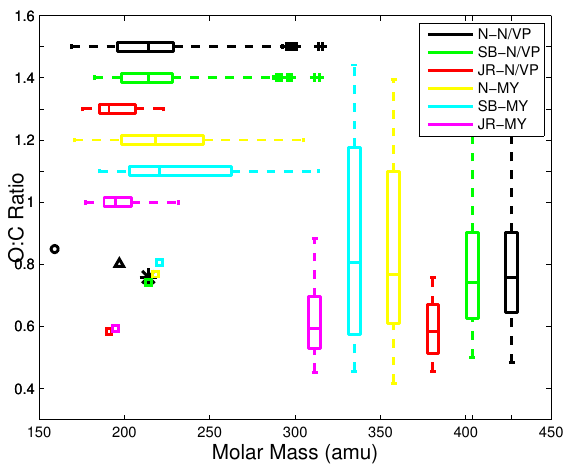
Fig. 7. The distribution of the average O:C ratios and molar masses of the predicted condensed SOA across all cases for 27 scenarios with the box-and-whiskers showing the median, interquartile and 95% ranges for each combination of estimation techniques ( γ i = 1 assumed in all cases); the coloured squares (and the black asterisk) show the median values for the corresponding box-whisker plots. The other black symbols refer to variants of the base case (all p 0 by N-N/VP method):- black circle- hydrolysed case (2727 compounds, γ i = 1); black triangle- non-ideal case ( γ i by UNIFAC).